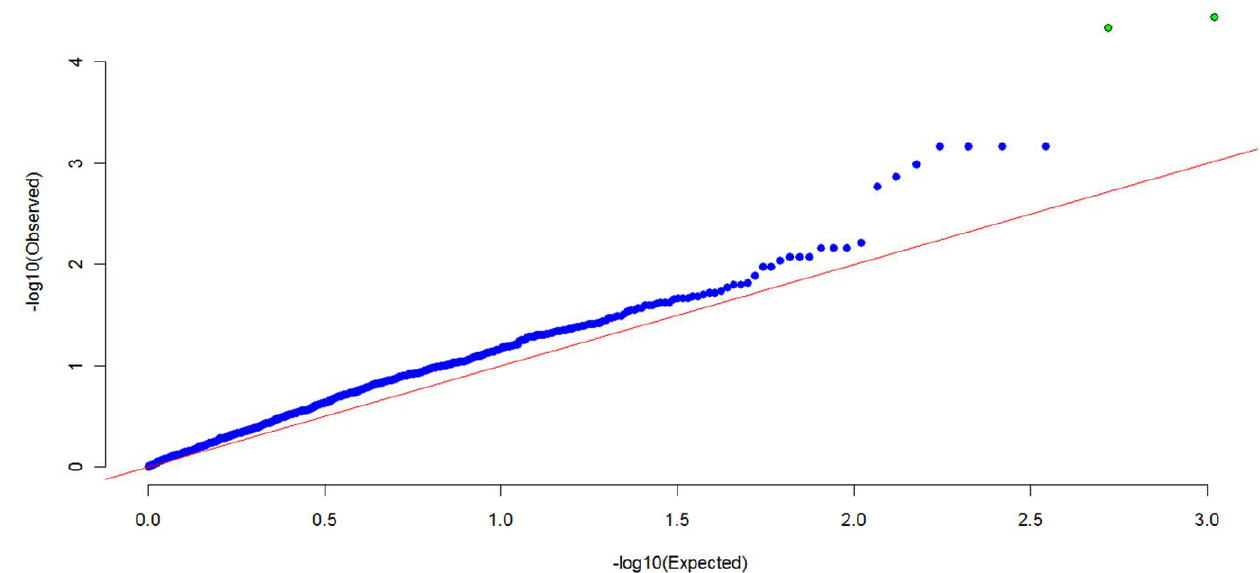
Figure 3. Q-Q plot of genome-wide MPPAS results of BMD at spine and hip.